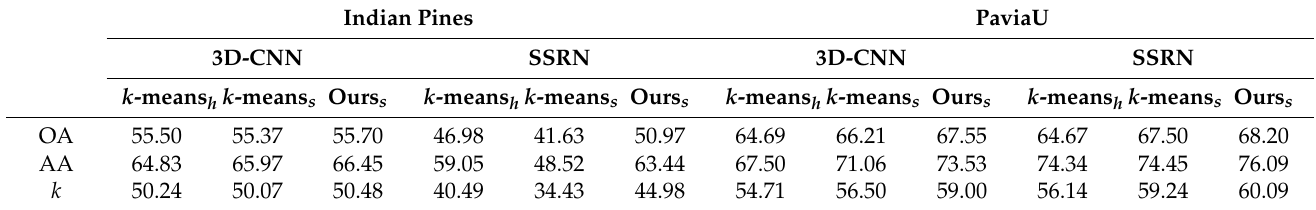
Table 14. Classification accuracy (%) with hard label obtained from -means method, soft label with the proposed method. The experiments were conducted with five training samples per class on the Indian Pines and PaviaU